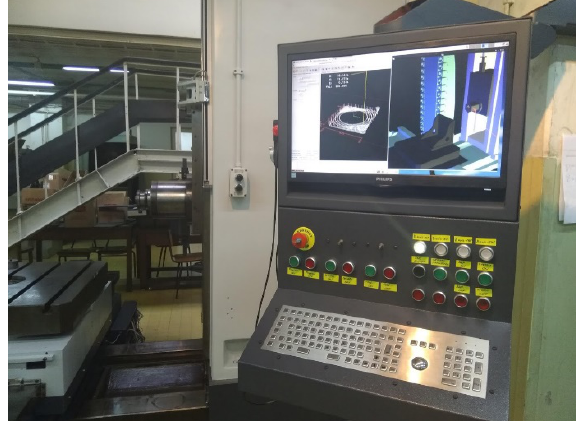
Figure 13. Virtual and real machine LOLA HBG 80 V3 during first